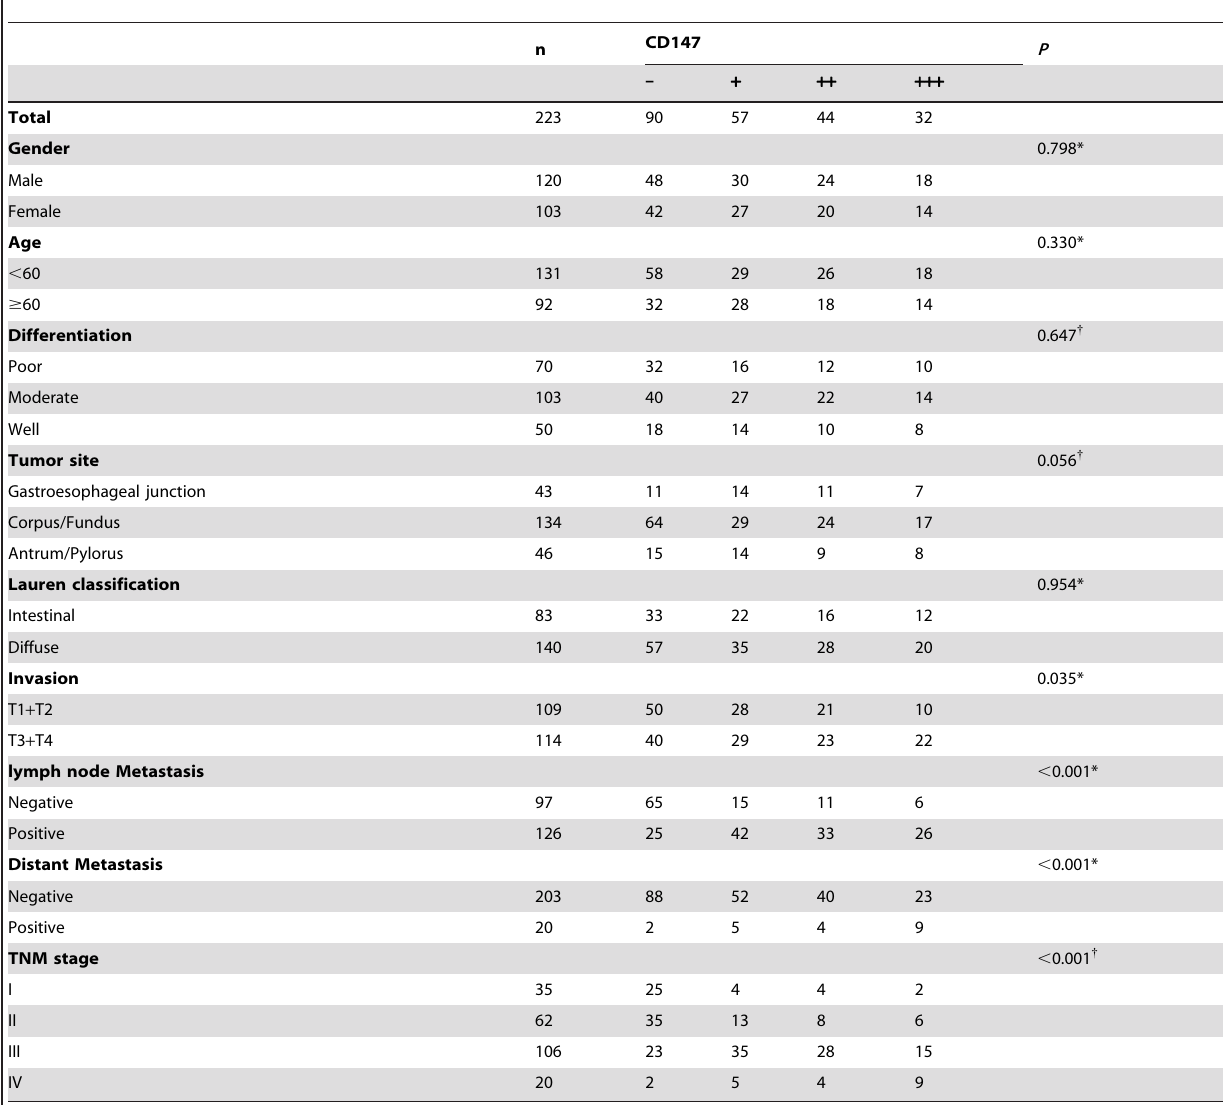
Table 1. Relationship between CD147 staining and clinicopathological